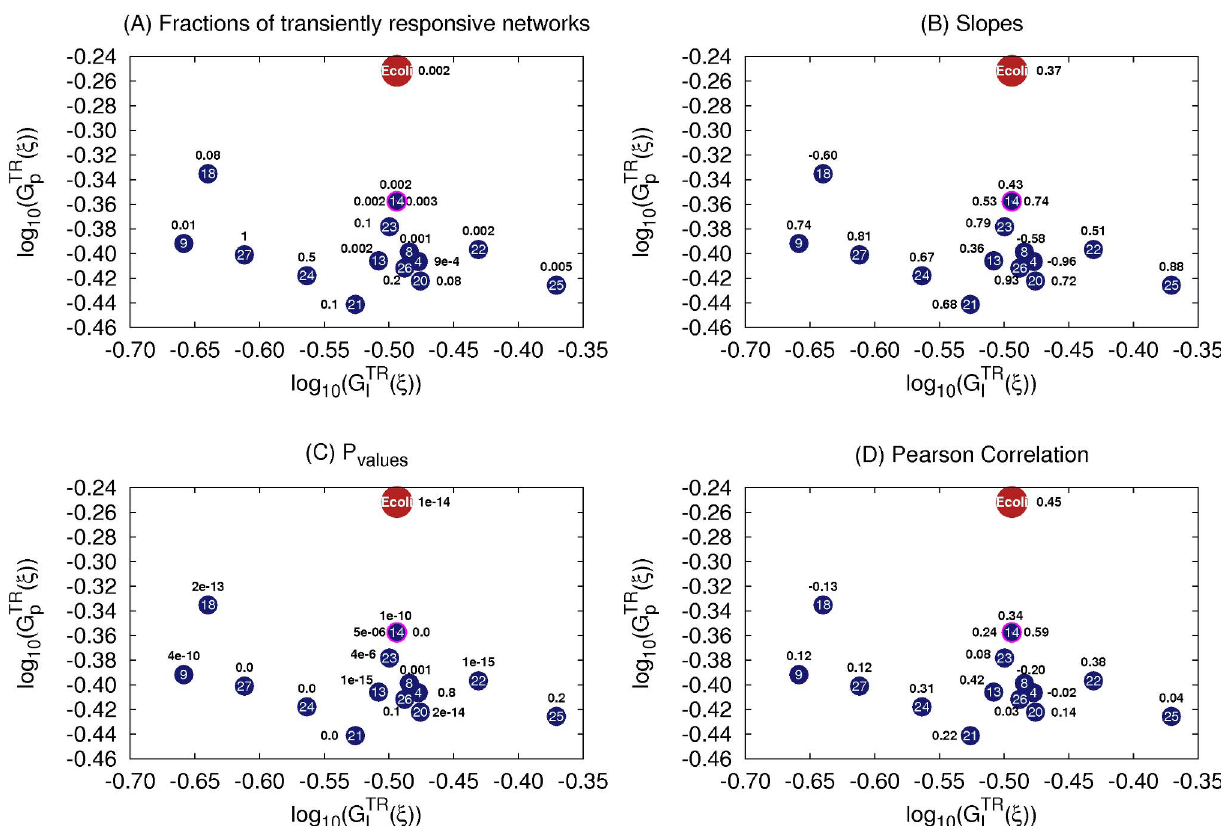
Figure 13. Chemotaxis networks responding to a change in a chemo-repellent. Each blue circle represents a topology responding to change in the concentration of chemo-repellents in the environment. The index of each topology is given inside the circle. The blue circle highlighted in red represent three topologies, 14, 15, and 17, whose positions overlap. Their corresponding values of fraction of TR network (A), slopes of the linear regression of their E I , E p values (B), p (C) and r (D) values of the regression are shown next to the blue circle.